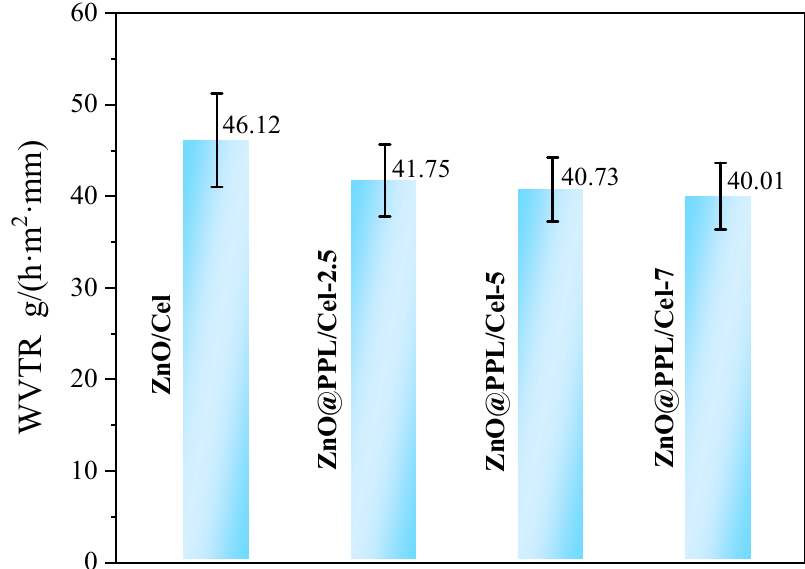
Figure 10. WVTR of ZnO/Cel and ZnO@PPL/Cel.